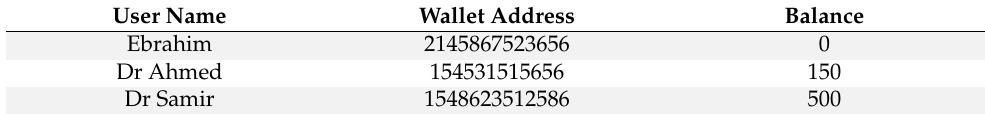
Table 7. User wallets after